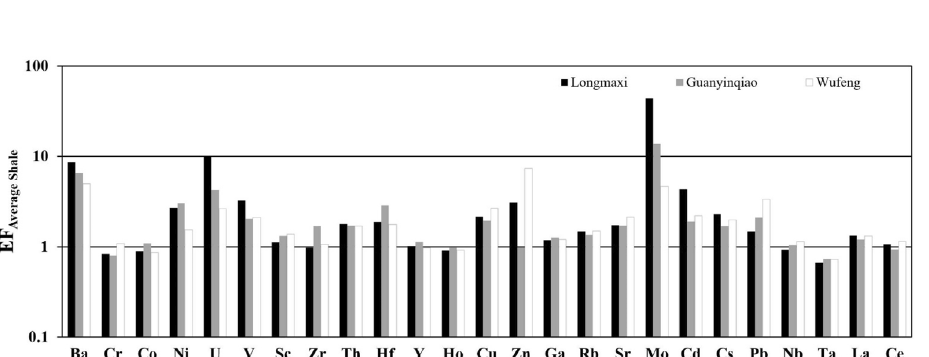
Figure 7. The EFs of trace elements relative to average shale in the Xindi No. 2 well. The horizontal line is the EF of average shale, which is equal to 1 to highlight the enrichment or depletion of